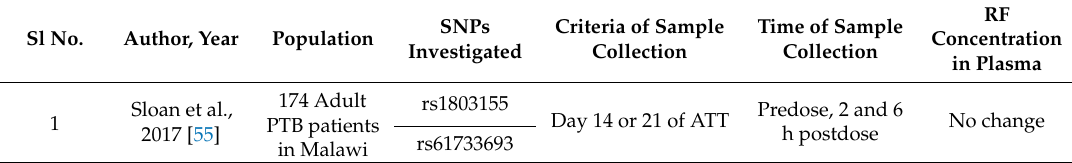
Table 6. Influence of AADAC genetic variants on plasma RF